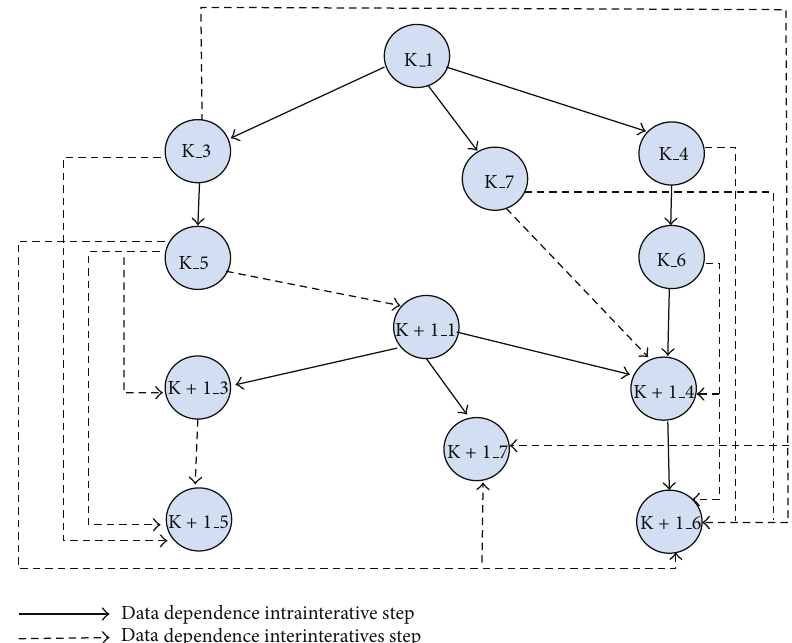
Figure 2: Data dependence between operations.